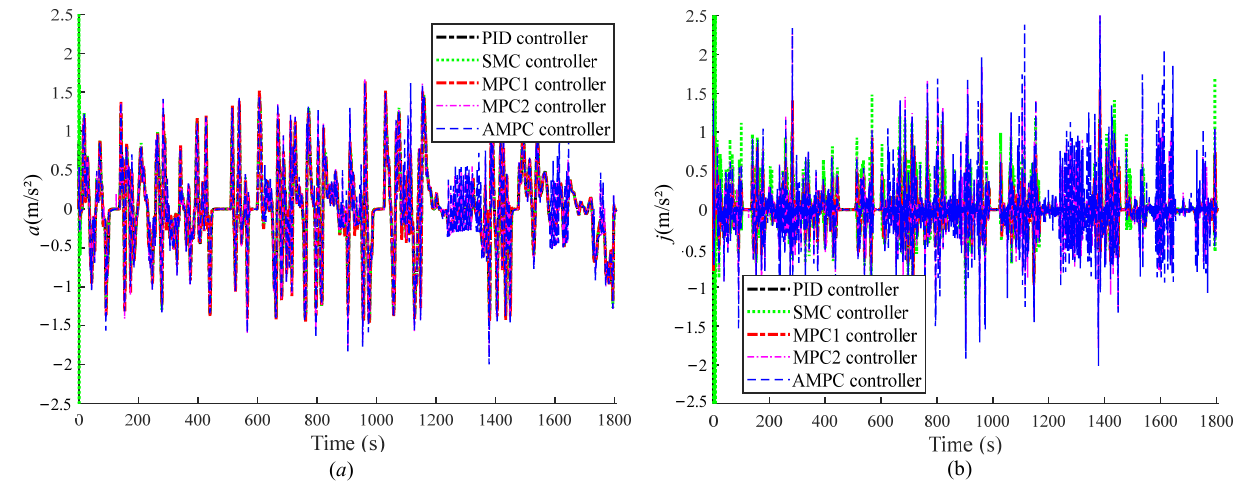
Figure 9. The acceleration and jerk of the host vehicle under each controller, ( a ) acceleration,( b ) jerk.